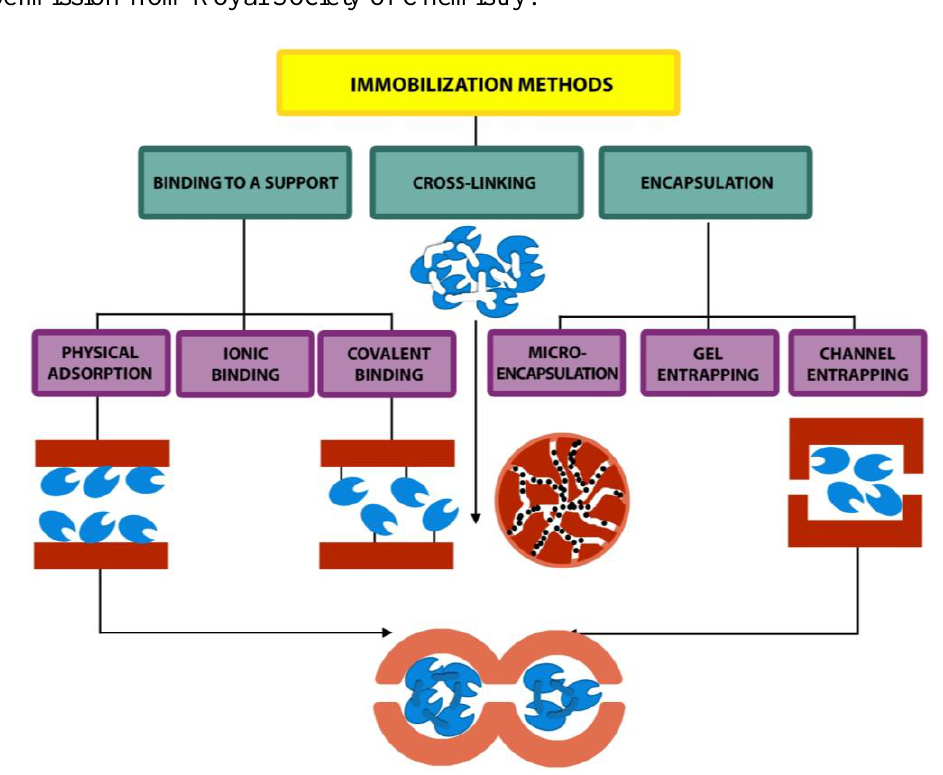
Figure 9. Enzyme Immobilization Methods [105]. Adapted from reference [94]. Printed with permission from Royal Society of